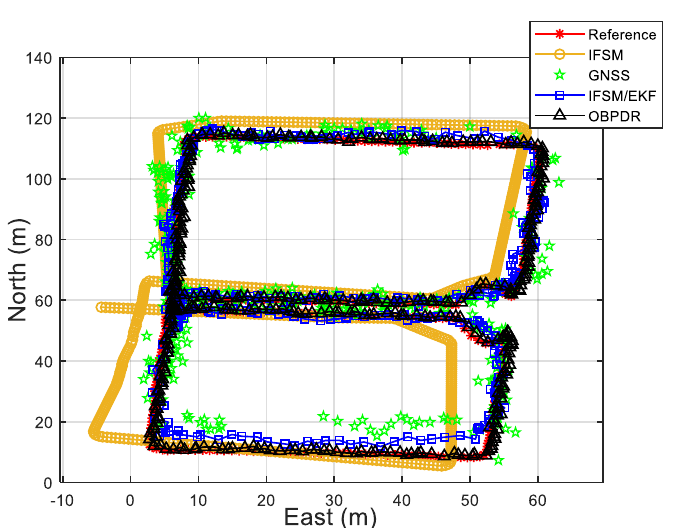
Figure 17. The positioning results of shadow experiment.